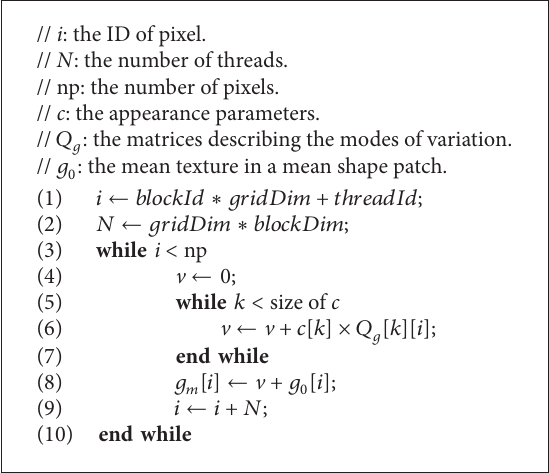
Algorithm 6: GPU-based method for calculating 𝑔 𝑚